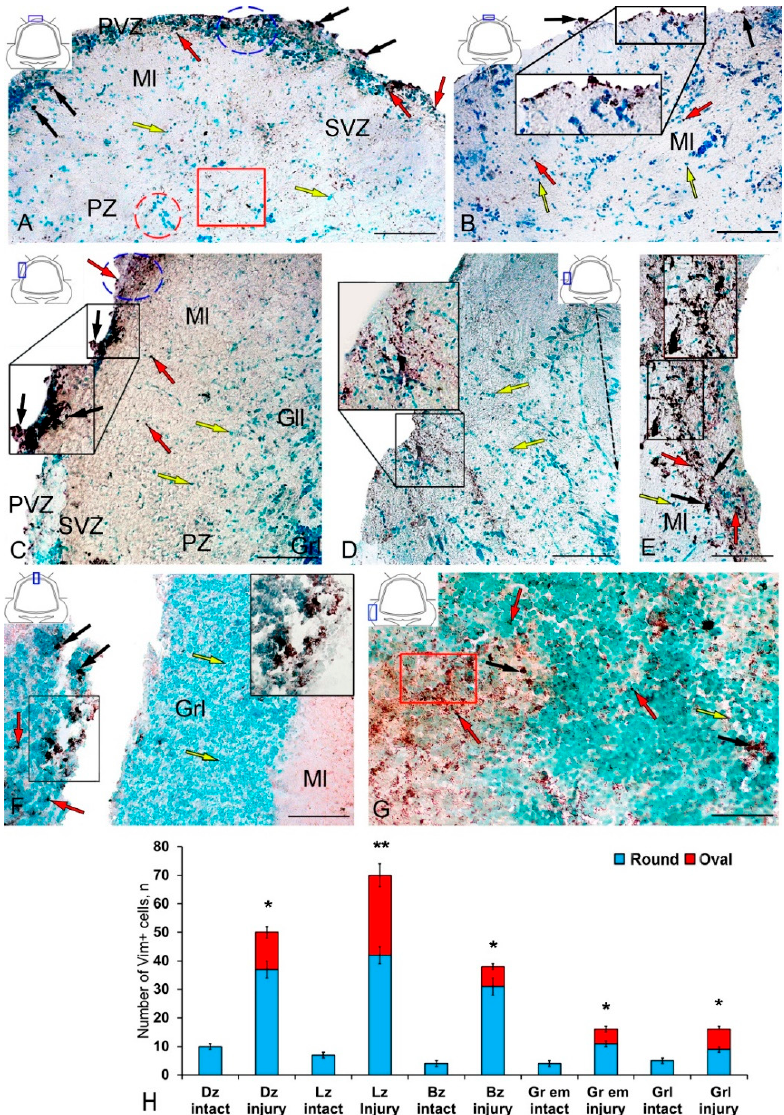
Figure 4. Distribution of nestin in the cerebellum of juvenile masu salmon Oncorhynchus masou on day 2 post-injury. ( A ) General view of the dorsal zone (DZ) in the rostral part of the cerebellum: Nes+ cells 1 type (red arrows), Nes+ cells 2 type (black arrows) and Nes − cells (yellow arrows); an aggregation of Nes+ cells (blue inset); an aggregation of Nes − cells (red inset), an aggregation of Nes+ granules (red rectangle); molecular layer (Ml); periventricular zone (PVZ), subventricular zone (SVZ), parenchymal zone (PZ). ( B ) General view of the DZ of the caudal part of the cerebellum: the aggregation of Nes+ cells in the PVZ of the molecular layer (black inset). ( C ) General view of the lateral zone (LZ) in the rostral part of the cerebellum: Nes+ cells in the PVZ of the molecular layer (black inset); an aggregation of Nes+ cells is outlined by the blue dotted oval; ganglionic layer (Gll); granular layer (Grl), and other designations see in Figure 4A. ( D ) LZ of the caudal part of the cerebellum: the black dashed arrow indicates the direction of migration of Nes − cells. ( E ) Large aggregation of Nes+ cells in the LZ (black inset). ( F ) General view of the injury area: asterisk indicates the injury area; a cluster of Nes+ cells in the injury area (black inset. ( G ) Granular eminences: aggregation of Nes+ granules (red rectangle). ( H ) Quantitative proportion of Nes+ cells in control and after traumatic injury. ( n = 5 in each group; * p ≤ 0.05 and ** p ≤ 0.01—significant differences vs. control groups). Student–Newman–Keuls test. IHC labeling of nestin. The blue rectangle in the pictogram indicates the corresponding area in the micrograph. Scale bars: ( A – G ) 100 μ m.